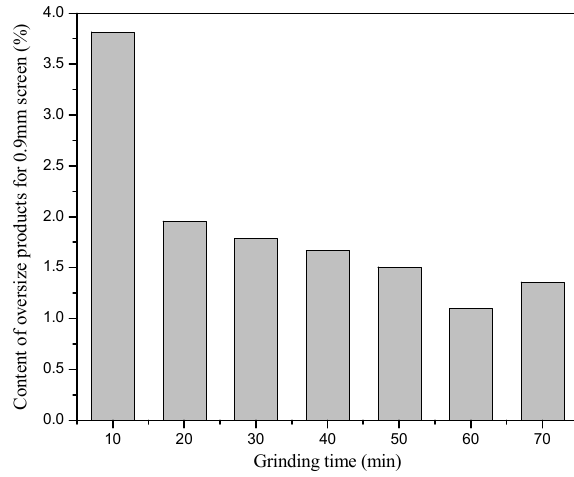
Figure 3. Proportion of oversize substances of steel slag powder vs. grinding time.